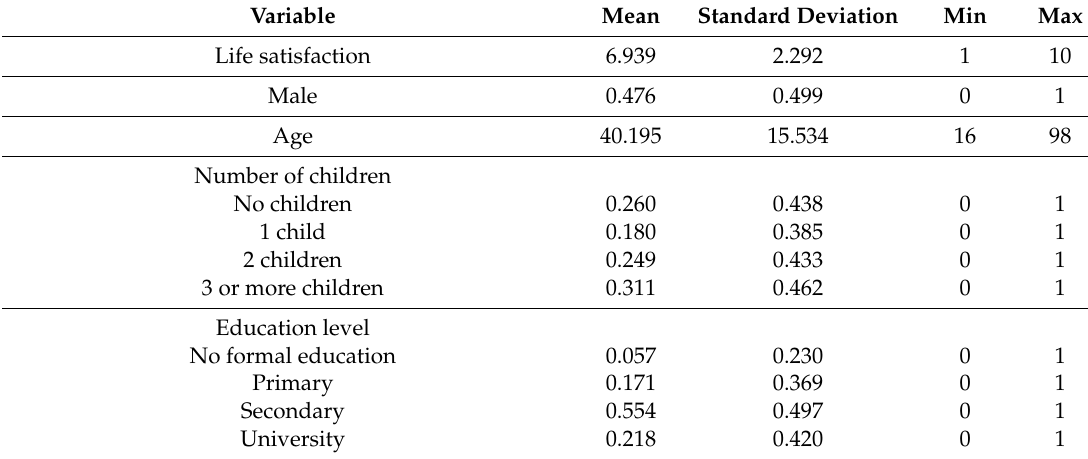
Table A1. Summary